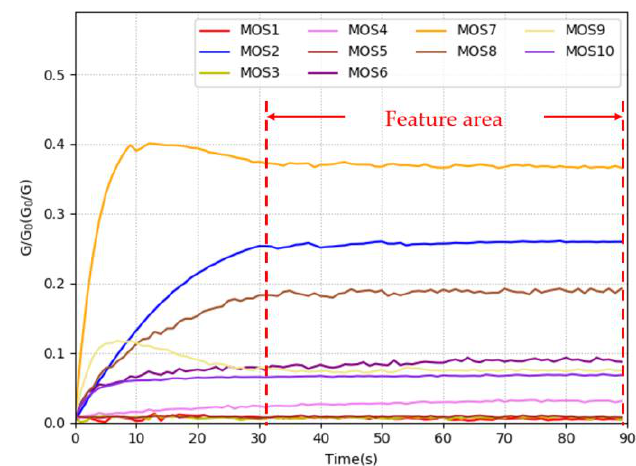
Figure 2. An example of the response curves of the E-nose for pears during 90 s of collecting stage.